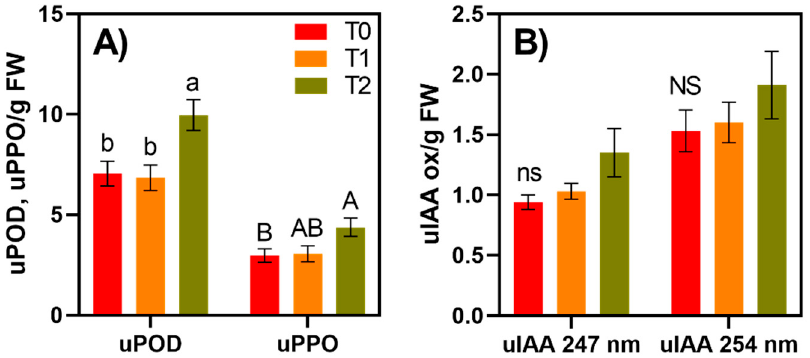
Figure 2. Change in enzymatic activity by time (T0 = immediately after apple cut, T1 = 1 h after cut, T2 = 24 h after cut): ( A ) = peroxidase units (uPOD) and polyphenol oxidase units (uPPO); ( B ) = indole-3-acetic acid oxidase units/g FW (uIAAox) over time. Means displayed are averages from all 14 cultivars. Means ± standard error displayed. Different letters above bars indicate differences according to Tukey post-hoc mean comparison at a p < 0.05. NS (non-significant difference) for IAA ox at either absorbance across time points. No significant interactions were detected by cultivar x time for enzymatic activities when assessed by ANOVA at p < 0.05.